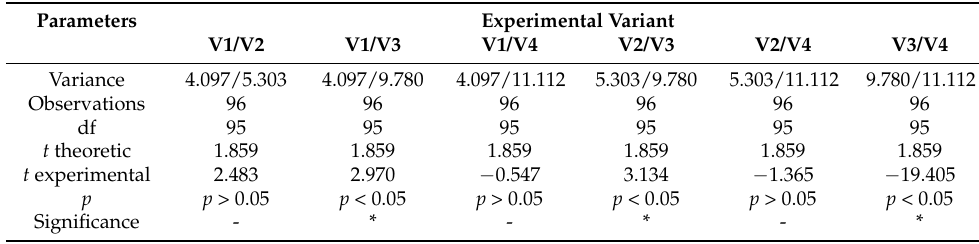
Figure 6. Average curves of microdrilling resistance in relation with diameter and planting variant. A two-way t -test indicated that there was no significant correlation between the V1 and V2, V1 and V4, and V2 and V4 variants, while differences between variants V1 and V3, V2 and V3, and V3 and V4 were significant (Table 4). Table 4. Result summary of two-way t -tests for significance between four variants of experimental plot for microdrilling.